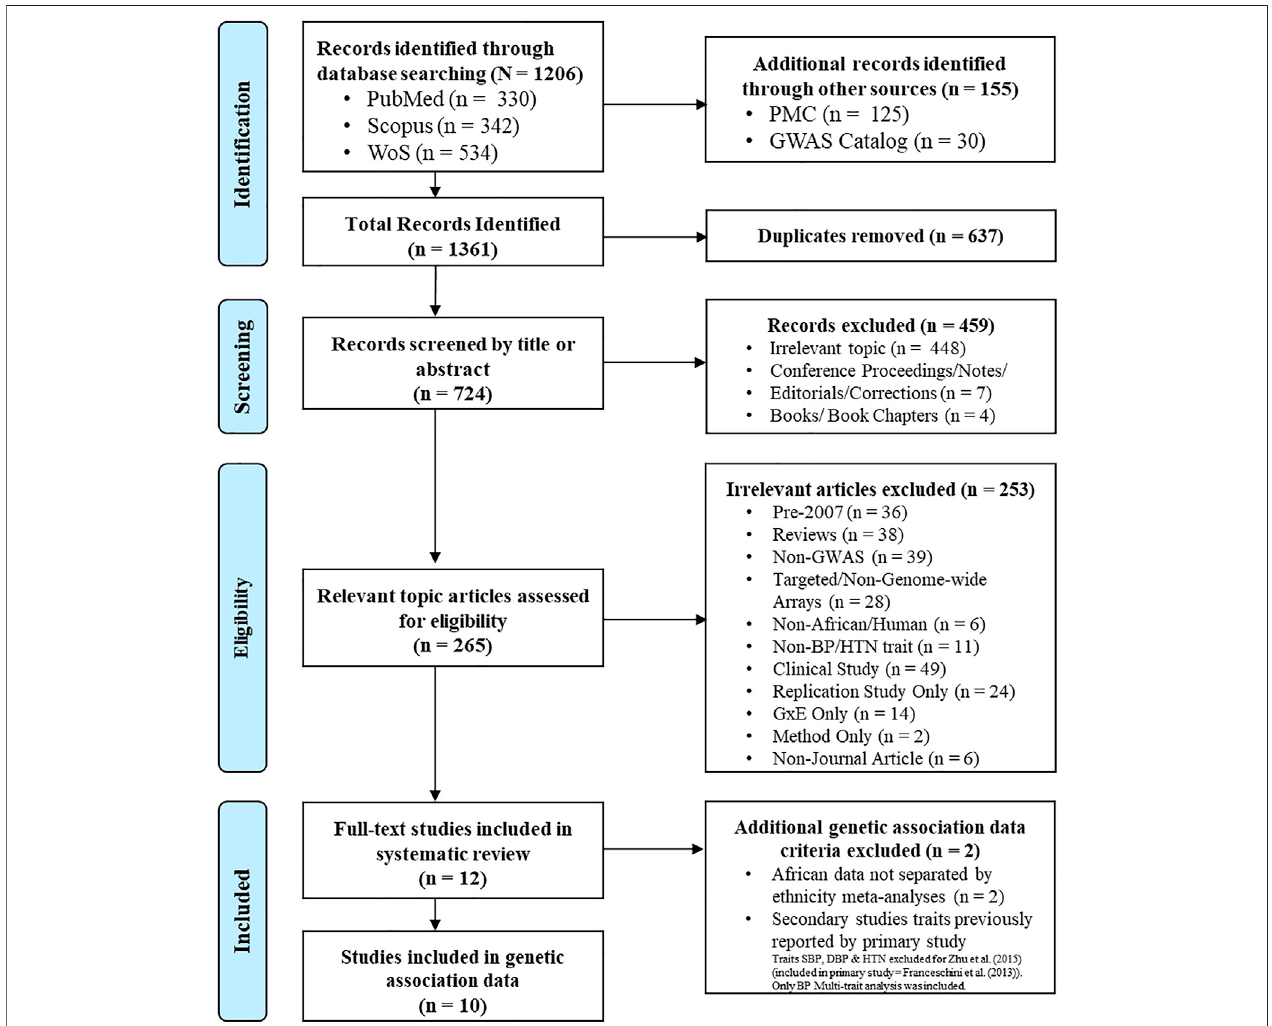
FIGURE 1 | Study schema. Study inclusion/exclusion criteria process, based on PRISMA 2009 fl ow diagram (Moher et al., 2009). Databases: PubMed (https:// pubmed.ncbi.nlm.nih.gov), Scopus (http://www.scopus.com), WoS (http://thomsonreuters.com/thomson-reuters-web-of-science), PMC (https://www.ncbi.nlm.nih. gov/pmc) and GWAS Catalog